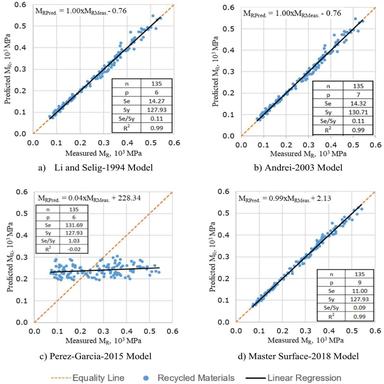
Predicted Values Vs. Measured MR for Recycled PCC Materials a) Li And Selig-1994 Model, b) Andrei-2003 Model, and c) Perez-Garcia-2015 Model d) Proposed Master Surface-2018 Model.